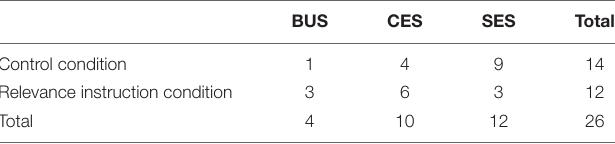
TABLE 7 | Distribution of strategies across